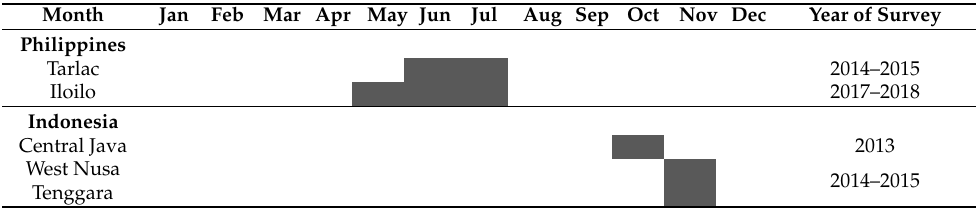
Figure 4. Principal component scores for ( a ) local weather characteristics and ( b ) local soil characteristics in the target sites. The x-axis represents the first component and the y-axis represents the second component. The first component is maximum air temperature, rainfall and wind speed for ( a ) and organic carbon and total nitrogen for ( b ). The second component is minimum air temperature for ( a ) and sand fraction for ( b ). Table 5. Sowing period for rainfed rice in Indonesia and the